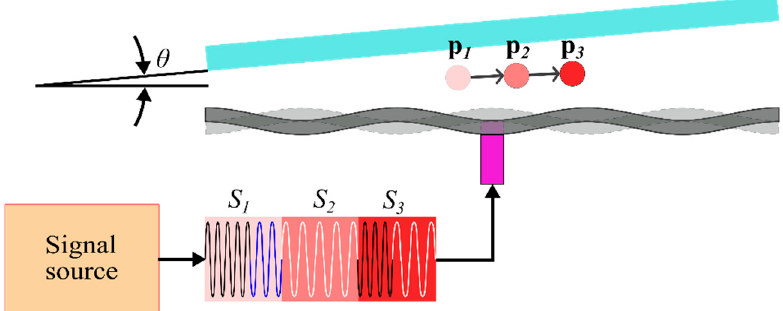
Figure 2. Schematic of the acoustic levitator; a particle is levitated at position 𝐩 (cid:3036) when signal 𝑆 (cid:3036) is played, 𝑖 =1,2,3. Tilting angle between surfaces of the transducer and the reflector is 𝜃 .